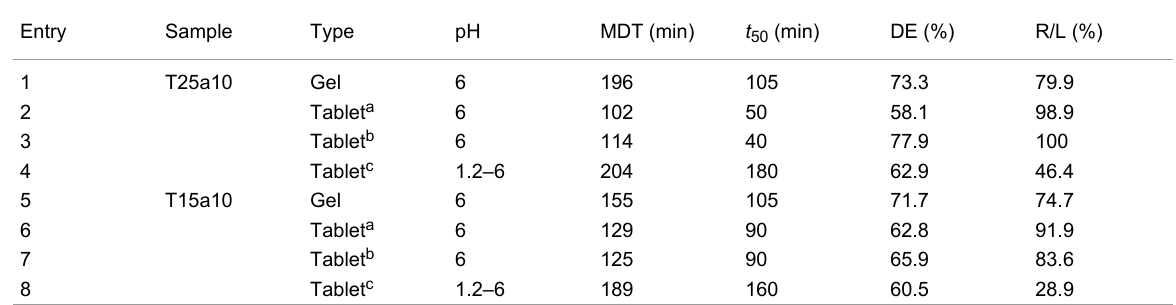
Table 2: Release parameters of gels and tablets loaded with